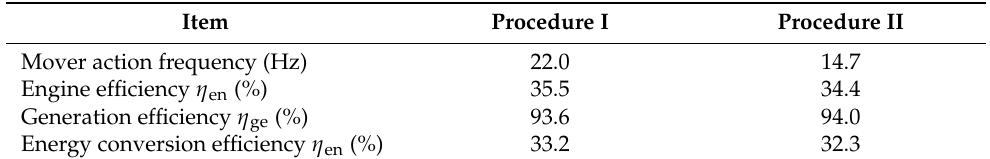
Table 2. Simulation results for energy conversion efficiency.